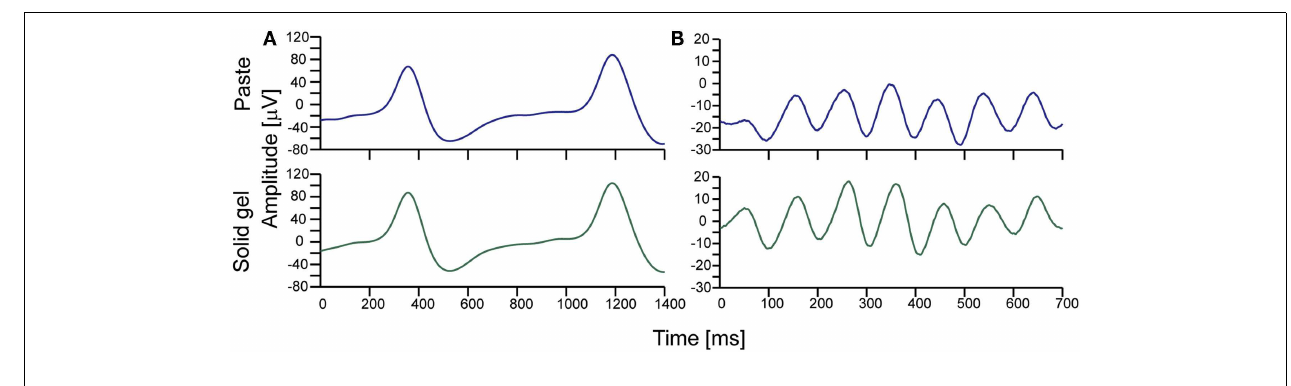
obtained with the paste-based and solid-gel-based electrodes, respectively.The signals were collected with an in-house EEG amplifier (24bit, 1024Hz).The represented data were obtained through an eighth-order bandpass filter